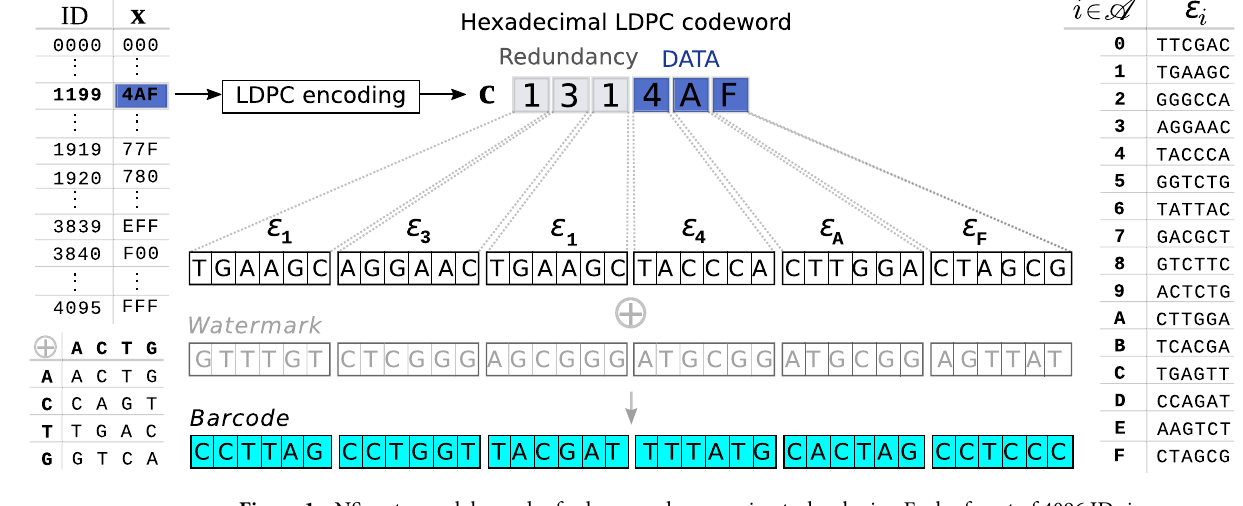
Figure 1. NS-watermark barcodes for long-read sequencing technologies. Each of a set of 4096 IDs is expressed as sequence of k = 3 symbols from a hexadecimal alphabet A ( x , blue). A hexadecimal LDPC code systematically adds m = 3 redundant symbols (grey) to x to generate an LDPC codeword c of length n = 6 . In the example shown, x = 4AF maps to c = 131:4AF. A dictionary ε (right) translates symbols from A into unique short nucleotide sequences of size u = 6 , thereby converting c into a nucleotide sequence of size l = n × u = 36 . The Galois field addition ⊕ of an optional “watermark” sequence of size l produces the final target barcode sequence (cyan). The operator ⊕ is defined on the table on the bottom